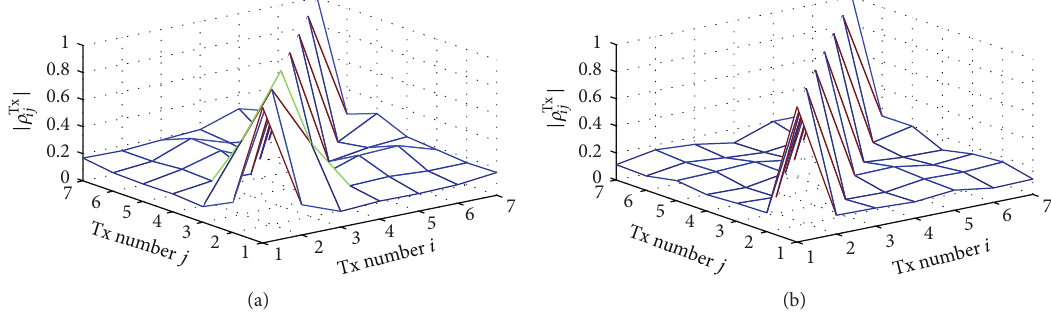
Figure 4: Transmitting correlation coefficients at (a) position R1 2 and (b) position R3 6 in office scenario.